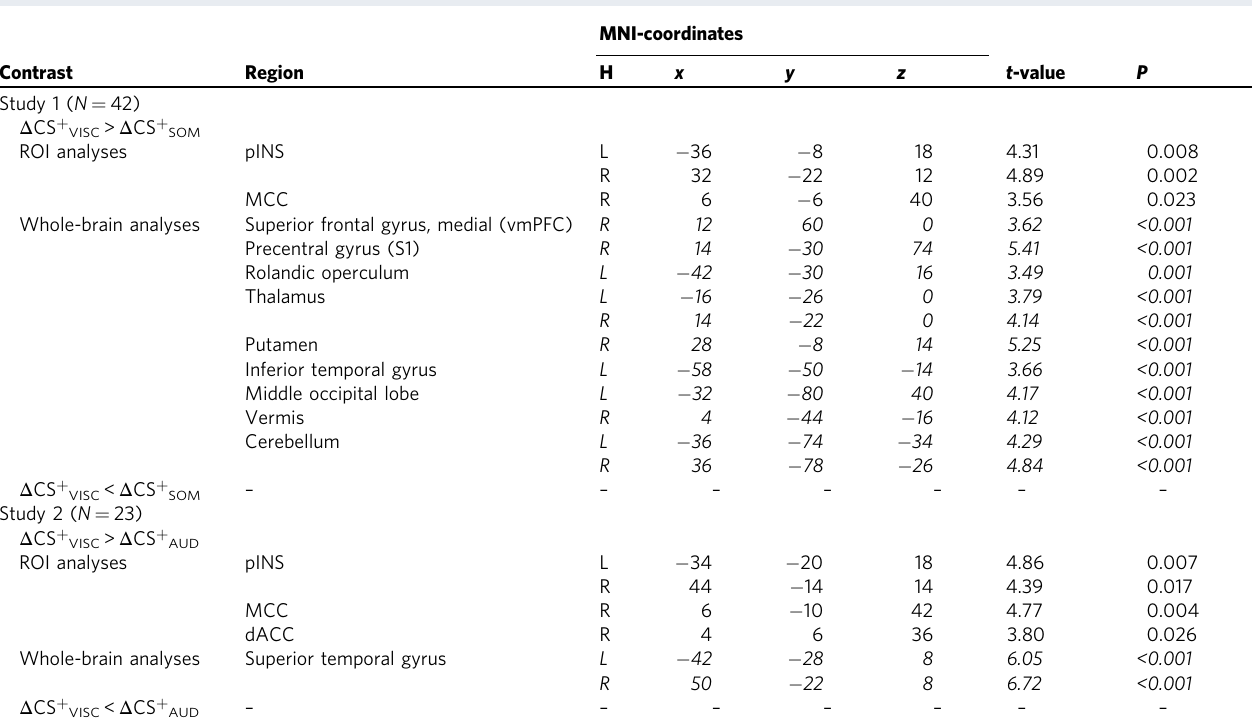
Table 3 Differences in neural activation induced by cues (CS) predicting interoceptive versus exteroceptive threats during acquisition.